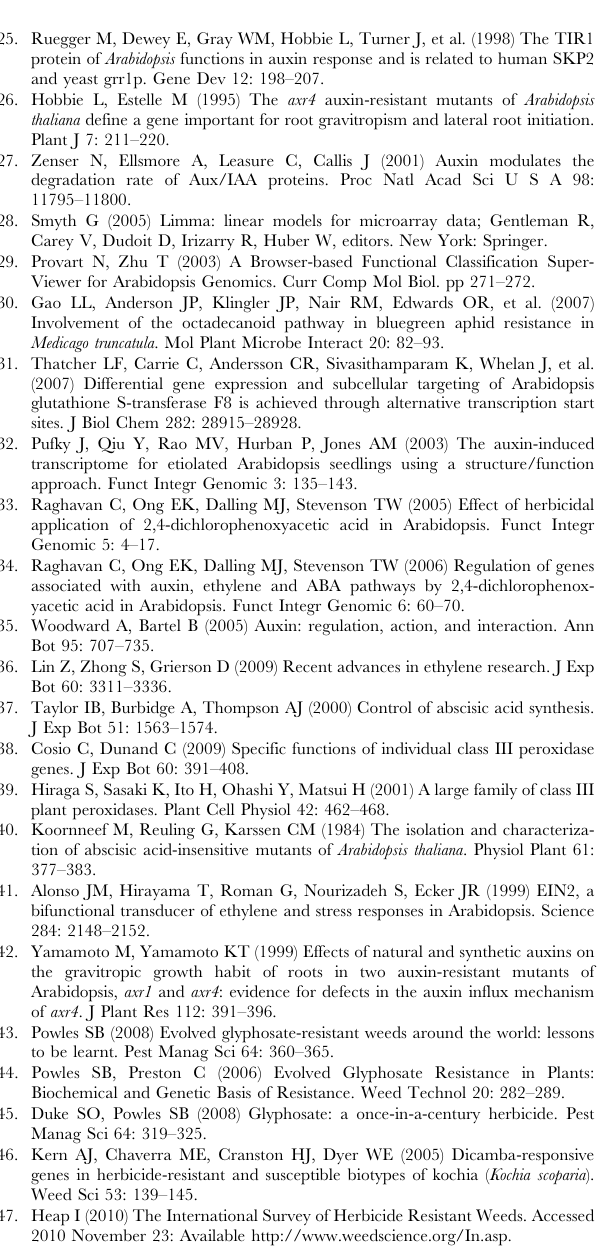
Table S1 Excel file of all 551 probe identifiers induced by dicamba 3 fold or more on the Arabidopsis Affyme- trix array. The ACC number, Affymetrix probe ID, Log 2 FC, and gene description are included for each gene. Table S2 Excel file of all 379 probe identifiers repressed by dicamba 3 fold or more on the Arabidopsis Affyme- trix array. The ACC number, Affymetrix probe ID, Log 2 FC, and gene description are included for each gene.